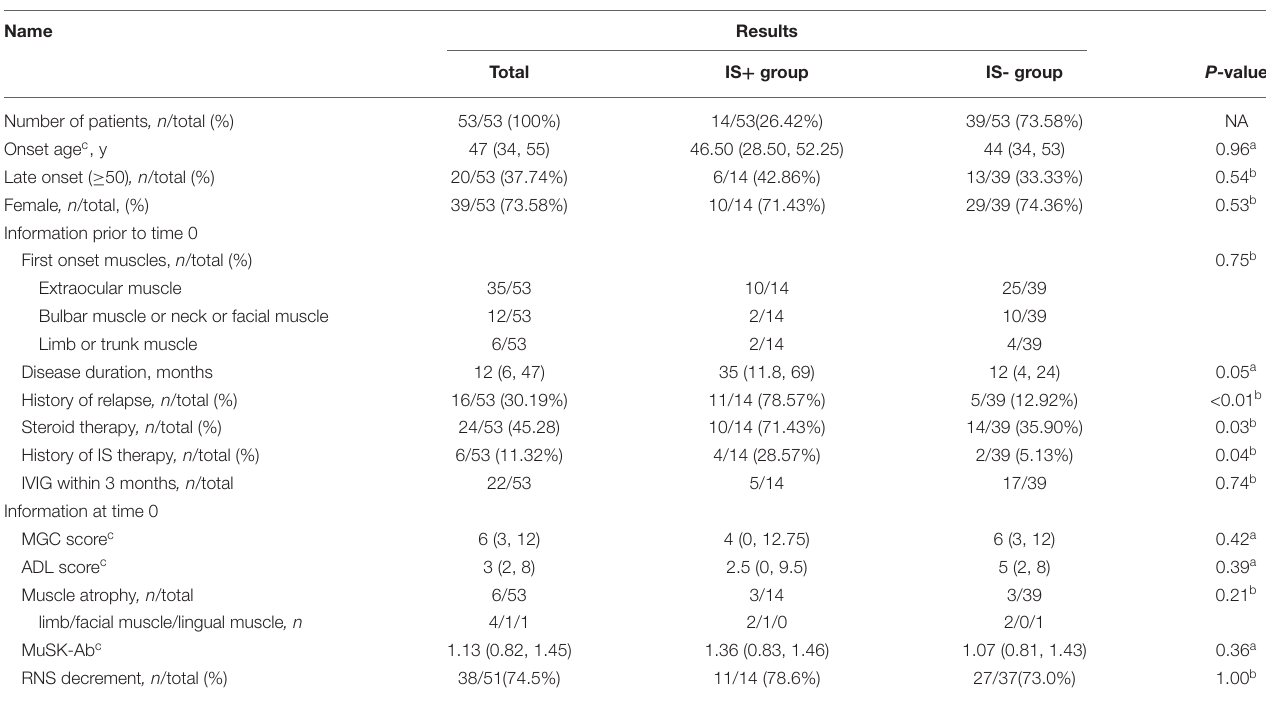
TABLE 1A | Baseline characteristics of